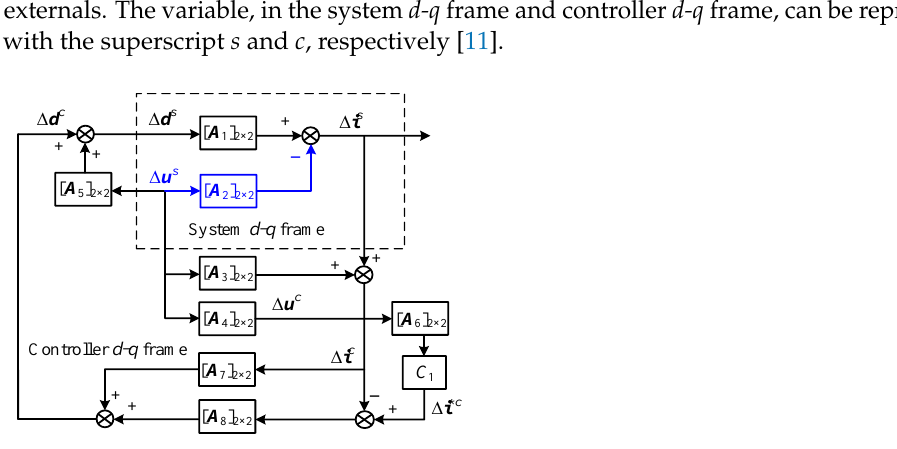
Figure 3. Small-signal model of grid-connected converter with conventional direct power control under forward power flow. under forward power